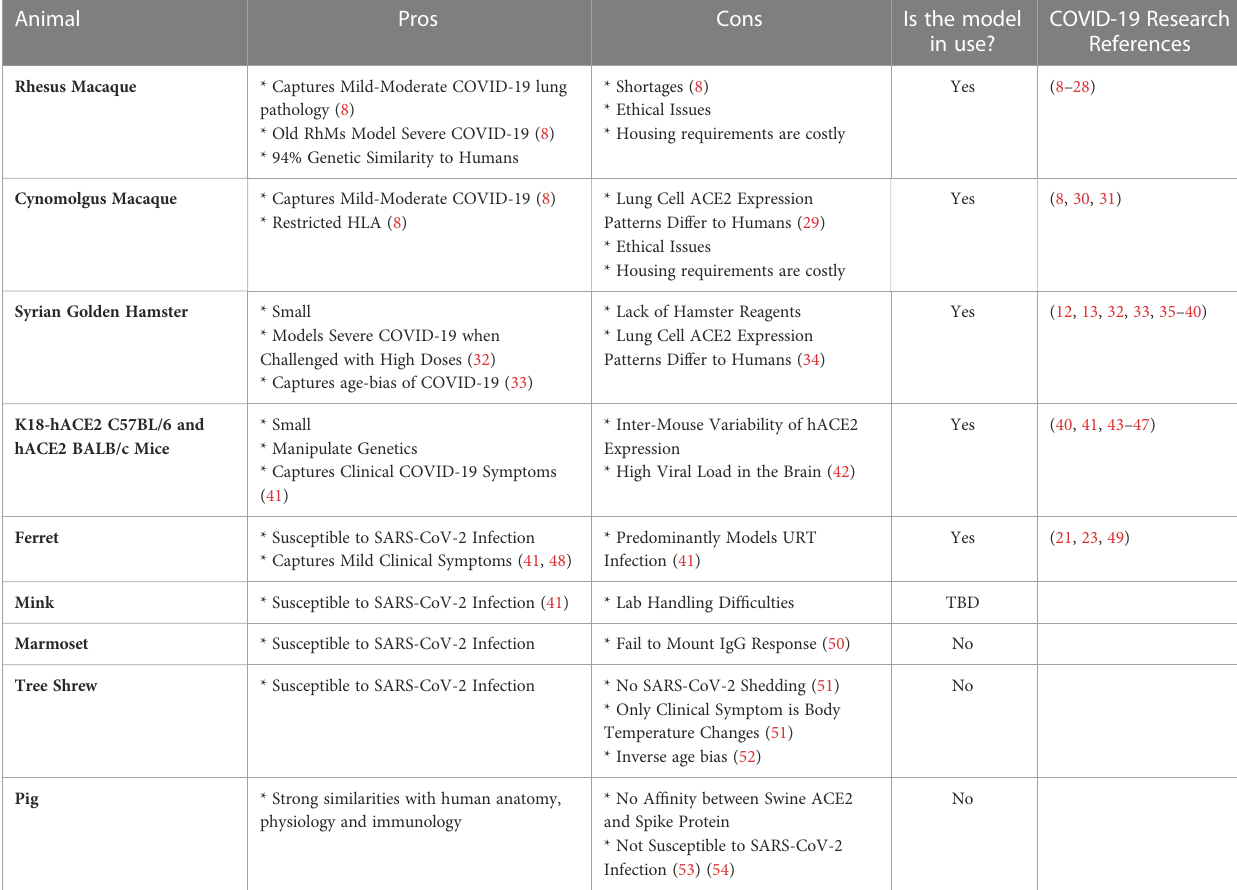
TABLE 1 Summary of the pros and cons associated with each model and the research papers discussed in this review that applied these models for the de fi nition of CoPs.